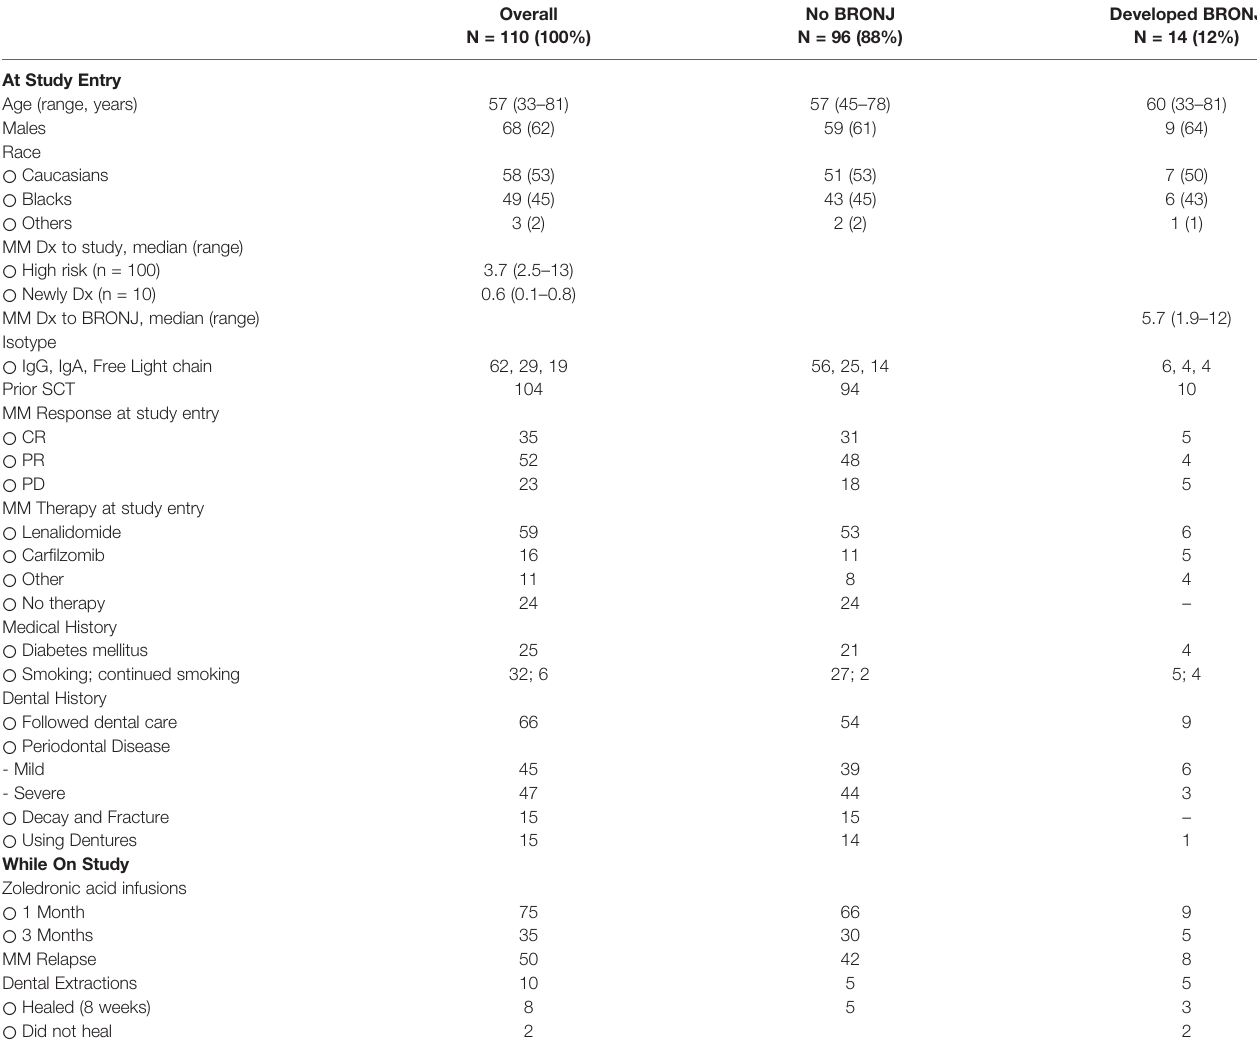
TABLE 1 | Demographics and characteristics of the study